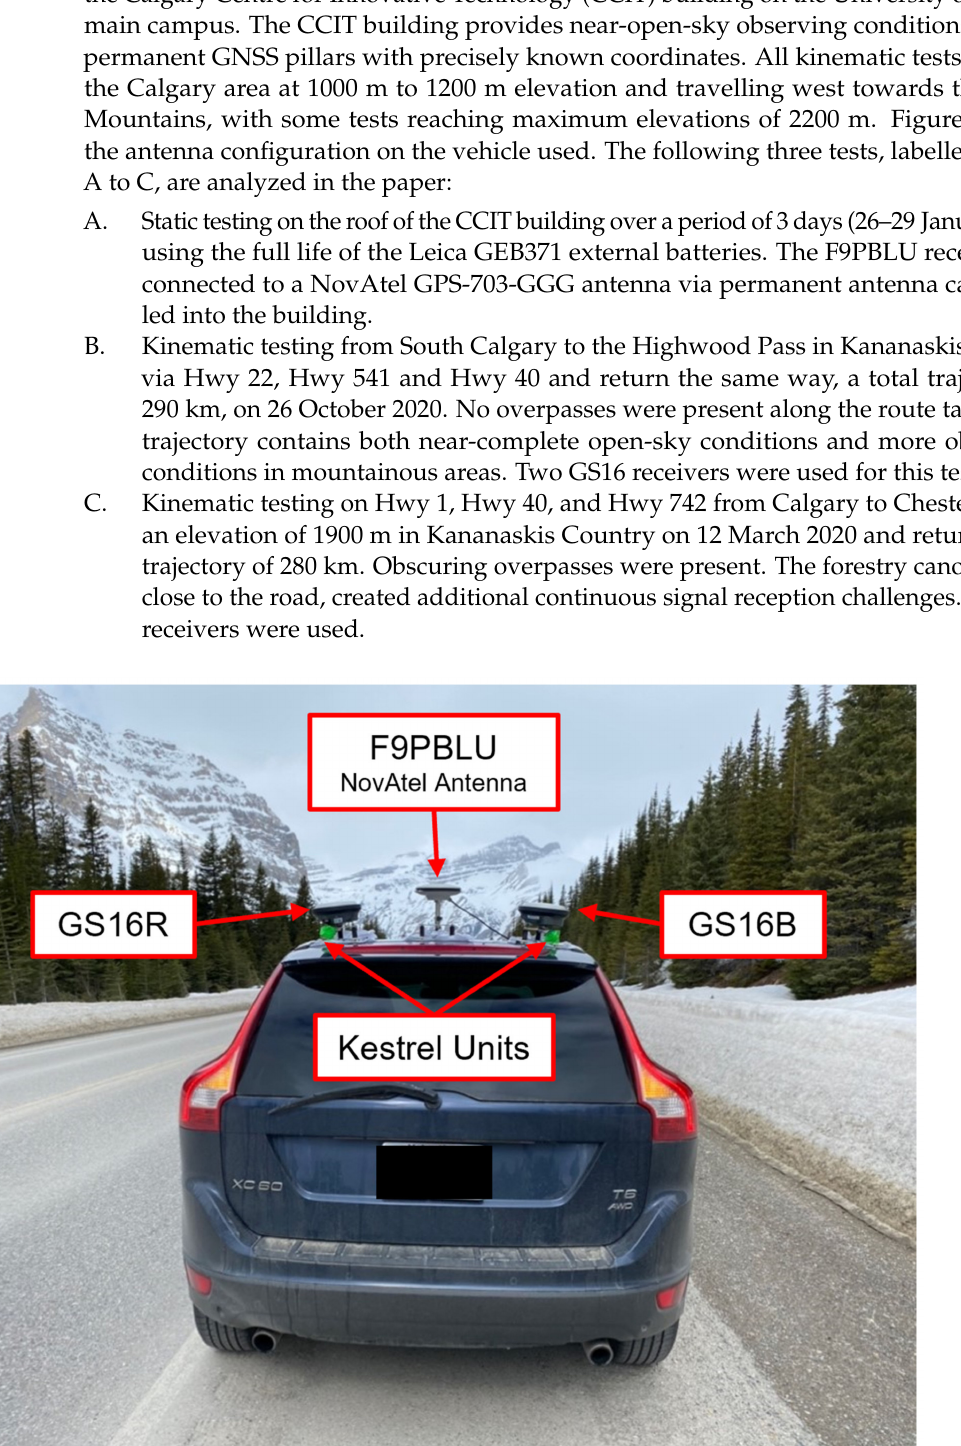
Figure 5. Typical configuration of GNSS receivers for kinematic testing. The Leica GS16 receivers are seen mounted to the rear of the roof on the left and right sides. The NovAtel antenna is mounted to the front center of the roof, connected to the F9P unit located inside the vehicle. Kestrel environmental data loggers are mounted to the magnet mounts of the GS16 receivers. (Photo taken at the Bow Pass, 2100 m elevation on the Icefield Parkway on 28 April